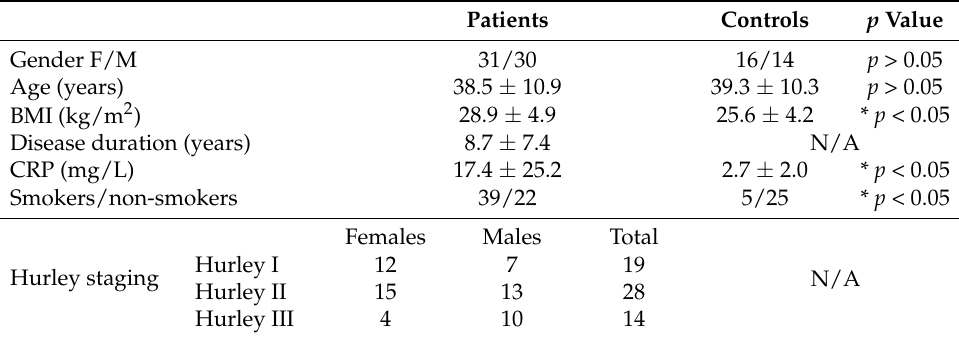
Table 1. Characteristics of population.